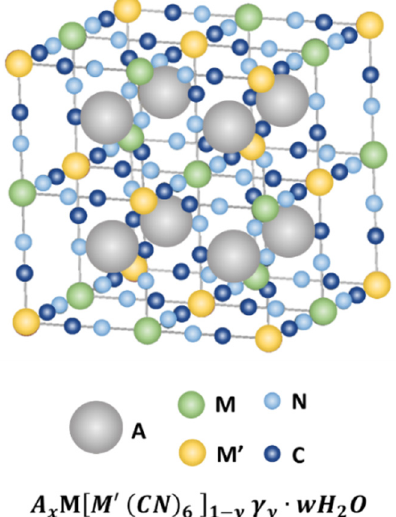
Figure 1. Schematic representation of the open-framework structure of a general PBA, where: A: alkaline cation, M,M’: transition metals, C: carbon, N: nitrogen. The structural water molecules have been omitted for the sake of clarity.